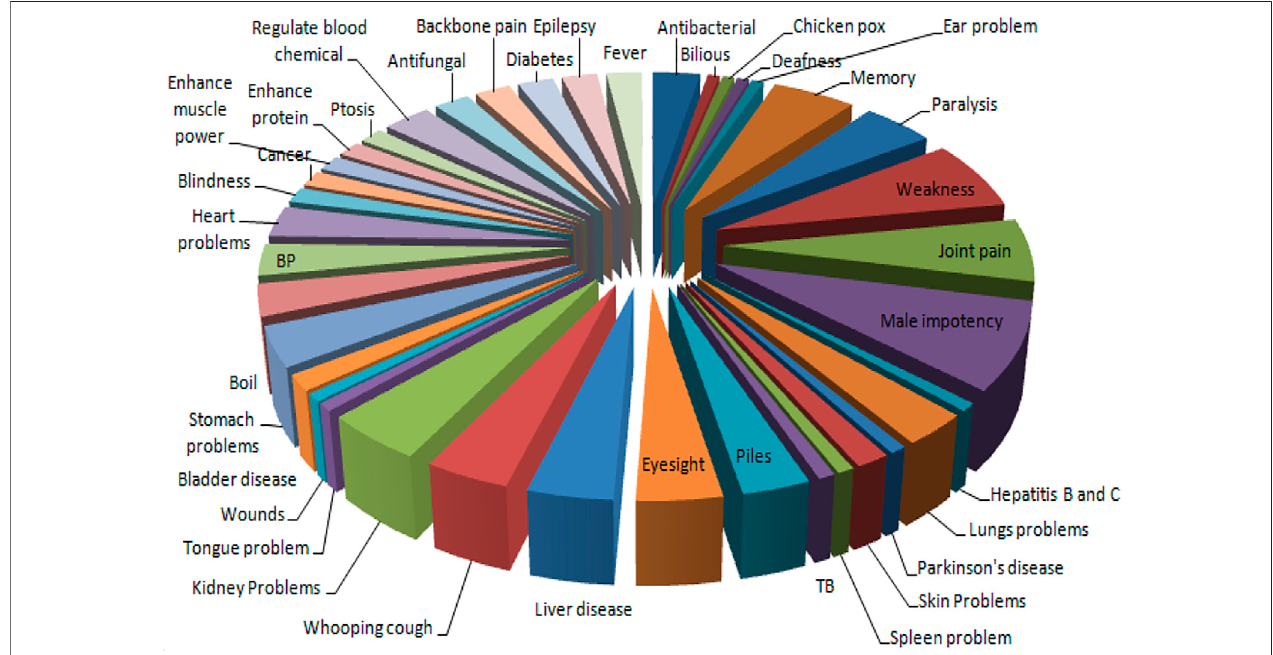
FIGURE 3 | Comparative analysis of species used to cure various ailments in the district Haveli, Azad Jammu and Kashmir.